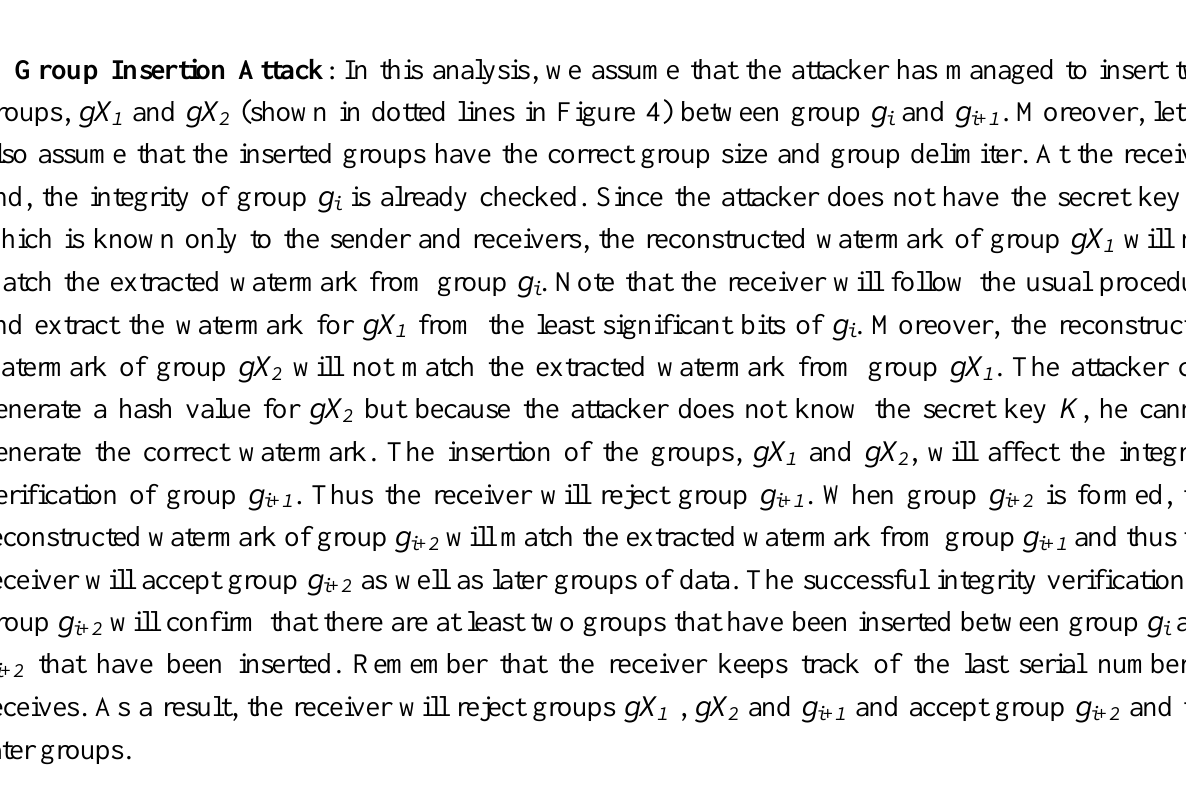
Figure 4. How FWC-D resists Groups Insertion Attack. Inserted fake groups g X and gX 1 2 group